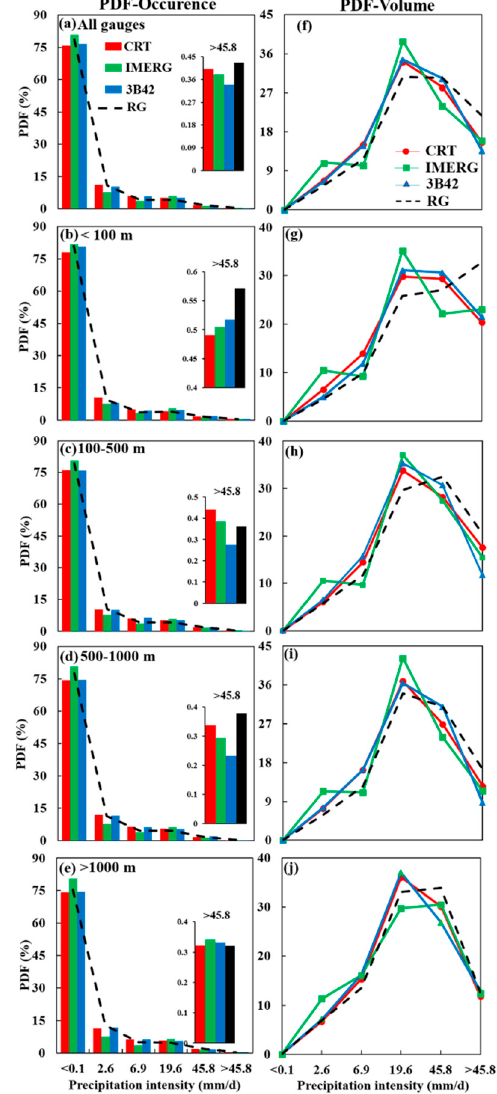
Figure 5. Occurrence probability distribution functions (PDFo) ( a – e ) and volume probability distribution functions (PDFv) ( f – j ) of precipitation estimate from CRT, IMERG, 3B42, and rain gauges over different elevation ranges.